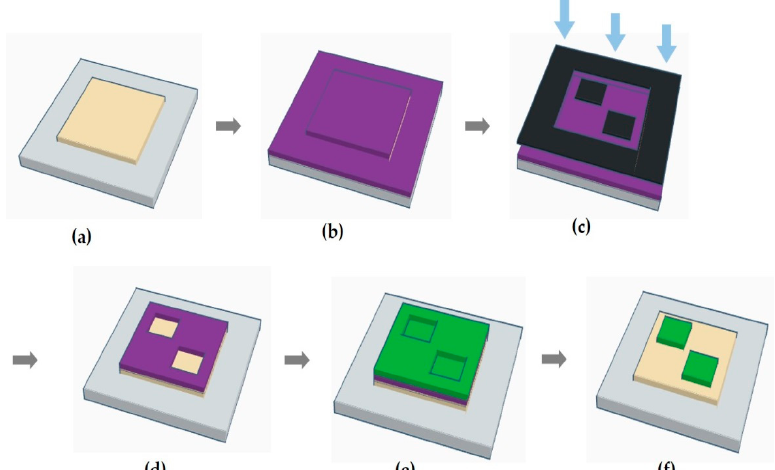
Figure 1. Schematic illustration of the photolithographic patterning process: ( a ) hole-transport layer (HTL) deposition on the indium tin oxide (ITO) substrate; ( b ) spin-coating of the photoresist (PR); ( c ) ultraviolet (UV) exposure through a photomask; ( d ) development of the photoresist film; ( e ) light-emitting layer (EML) deposition; ( f ) lift-off of the resist film and organic layer on it.